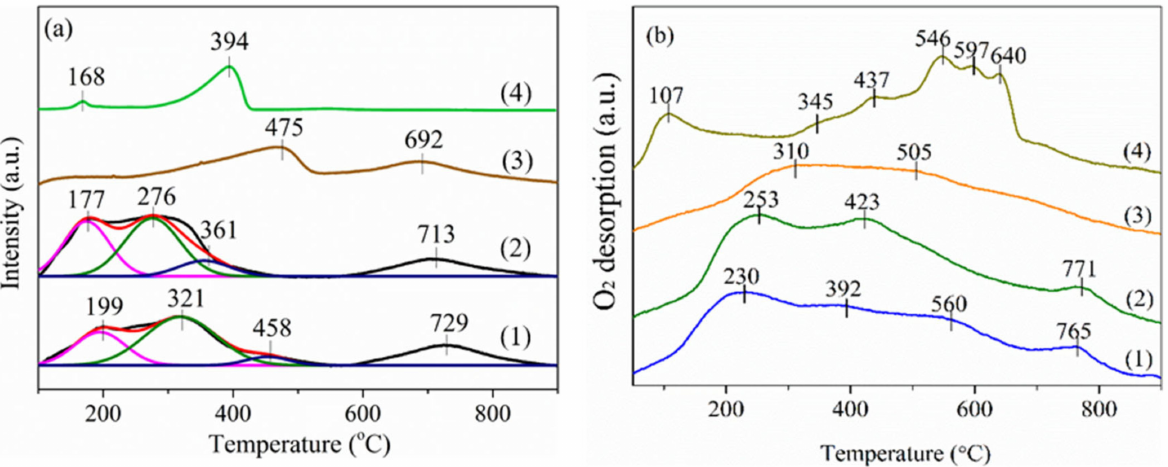
Figure 4. ( a ) H 2 -TPR and ( b ) O 2 -TPD profiles of (1) MnCe-L, (2) MnCe-H, (3) CeO 2 and (4) Mn 3 O 4